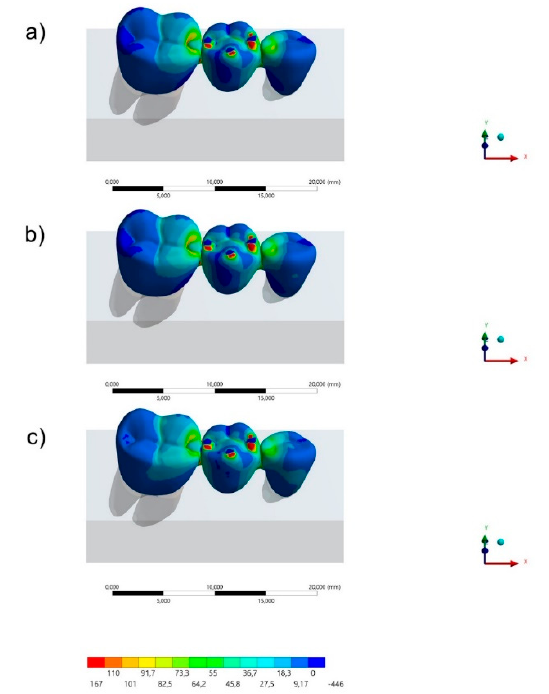
Figure 5. Occlusal view of the Maximum principal stress maps in the fixed partial denture (FDP) for each group: ( a ) AR, ( b ) PEEK and ( c ) RC.